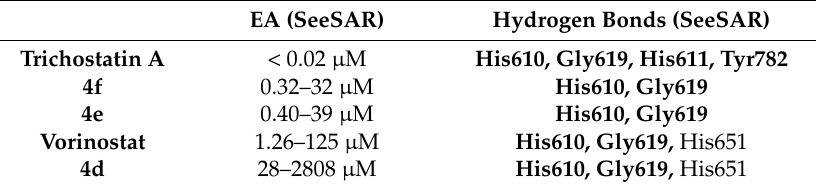
Table 5. SeeSAR docking results including estimated affinities (EA) and hydrogen bonds for HDAC6 structure 5EDU ordered by best estimated affinities. EA (SeeSAR) Hydrogen Bonds (SeeSAR)